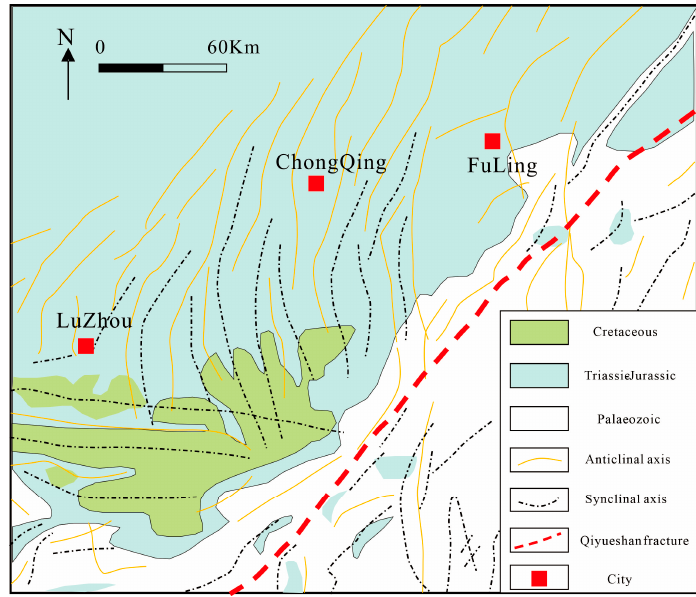
Figure 2. Outline of the structural plane in southeast Sichuan.